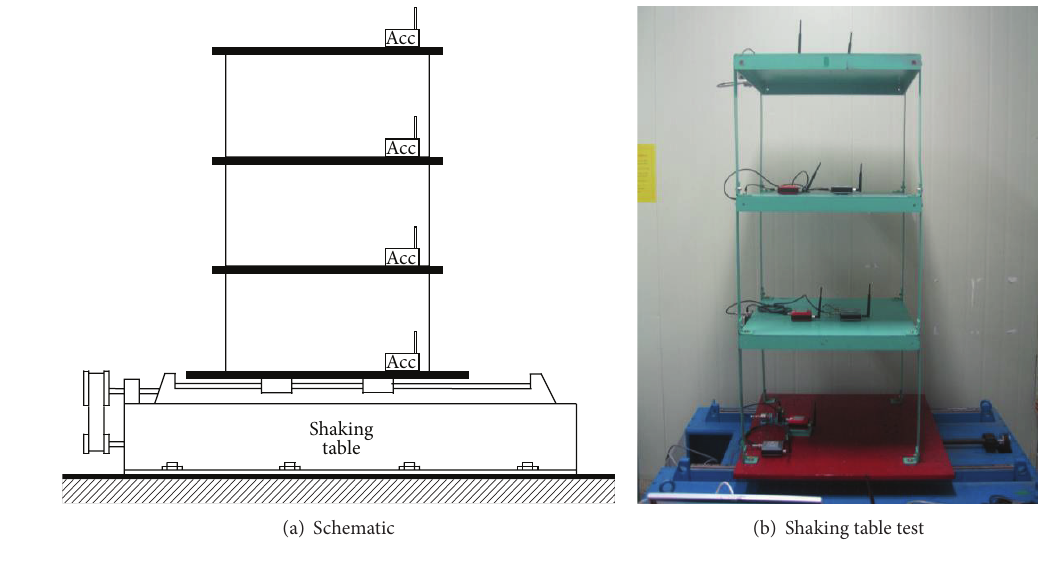
Figure 7: Shaking table test of a three-story building.